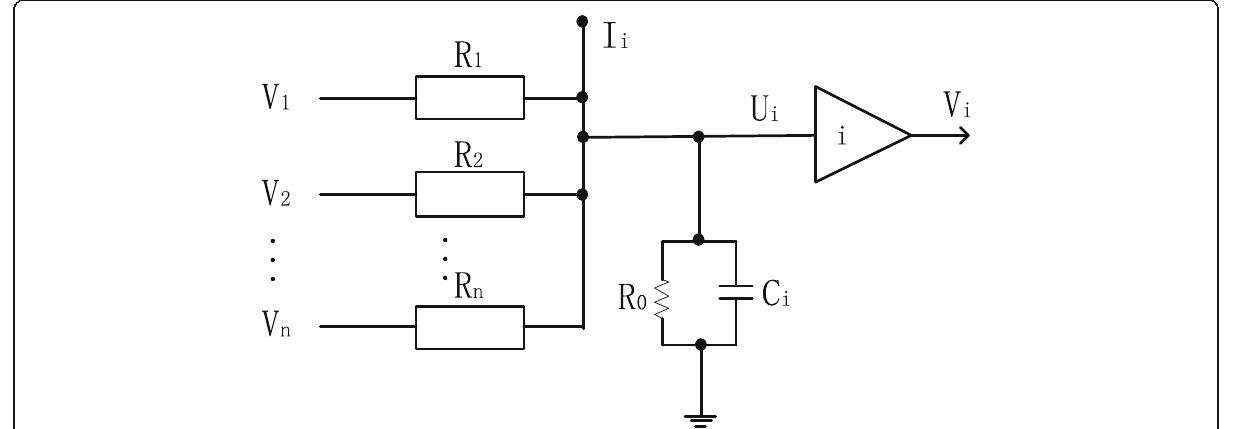
Fig. 1 CHNN circuit topology. Hopfield neural network equivalent to amplifying electronic circuits. Input information of each electronic component (neuron), including constant external current input, and feedback connection with other electronic